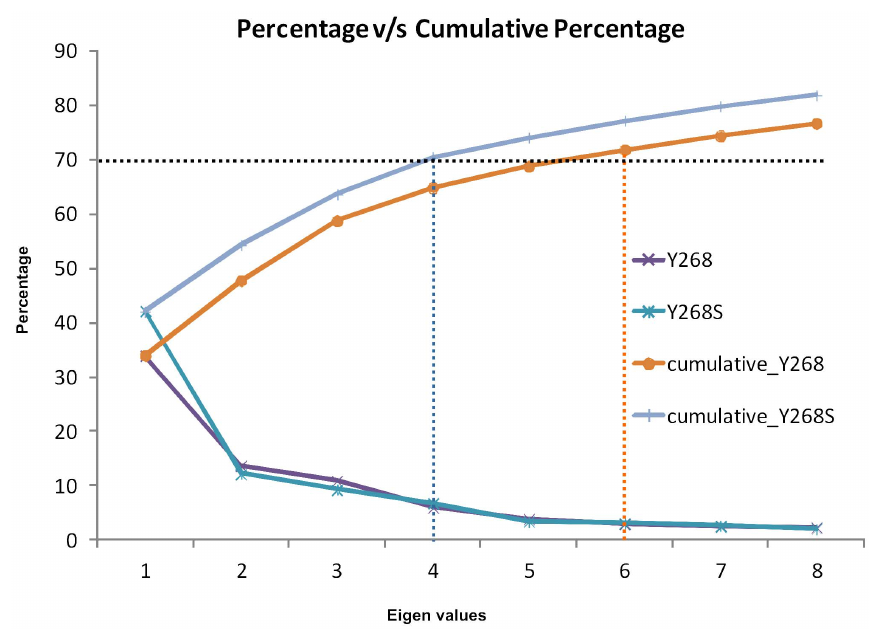
Figure 6. Proportion of variance and cumulative proportion of total variance of first ten eigenvalues of the wild (Y268) and mutant variant (Y268S) of P.falciparum